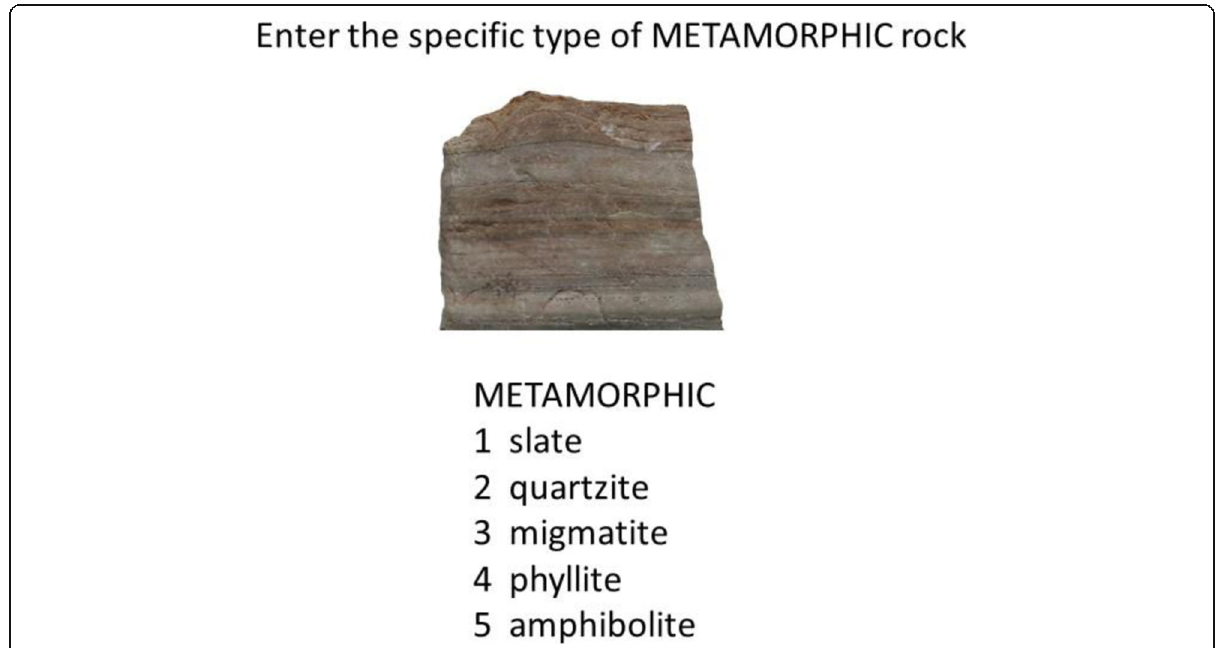
Fig. 4 Schematic example of the second stage of a typical trial from the training and test phases of condition 2 and the training phase of condition 3. The example assumes that the subject selected the high-level response “ Metamorphic ” during the first